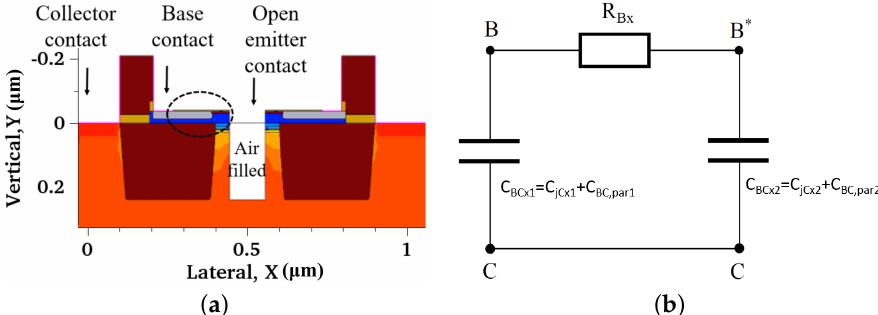
Figure 8. Customized TCAD structure ( a ) and RC equivalent circuit ( b ) representing the left circled region for the determination of cjcx + cbcpar . B is the external base node.